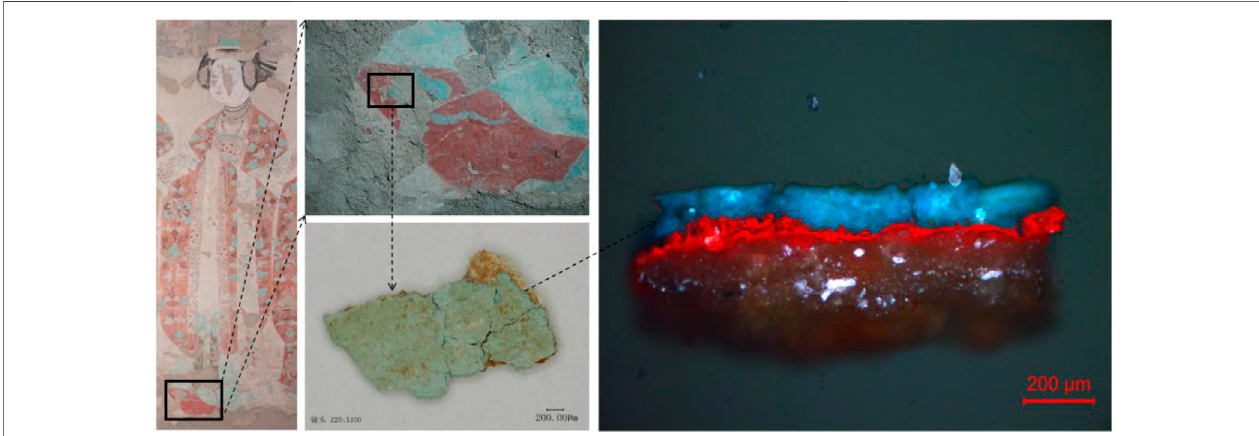
FIGURE 11 | Microscopy images of cross-sections for the mural